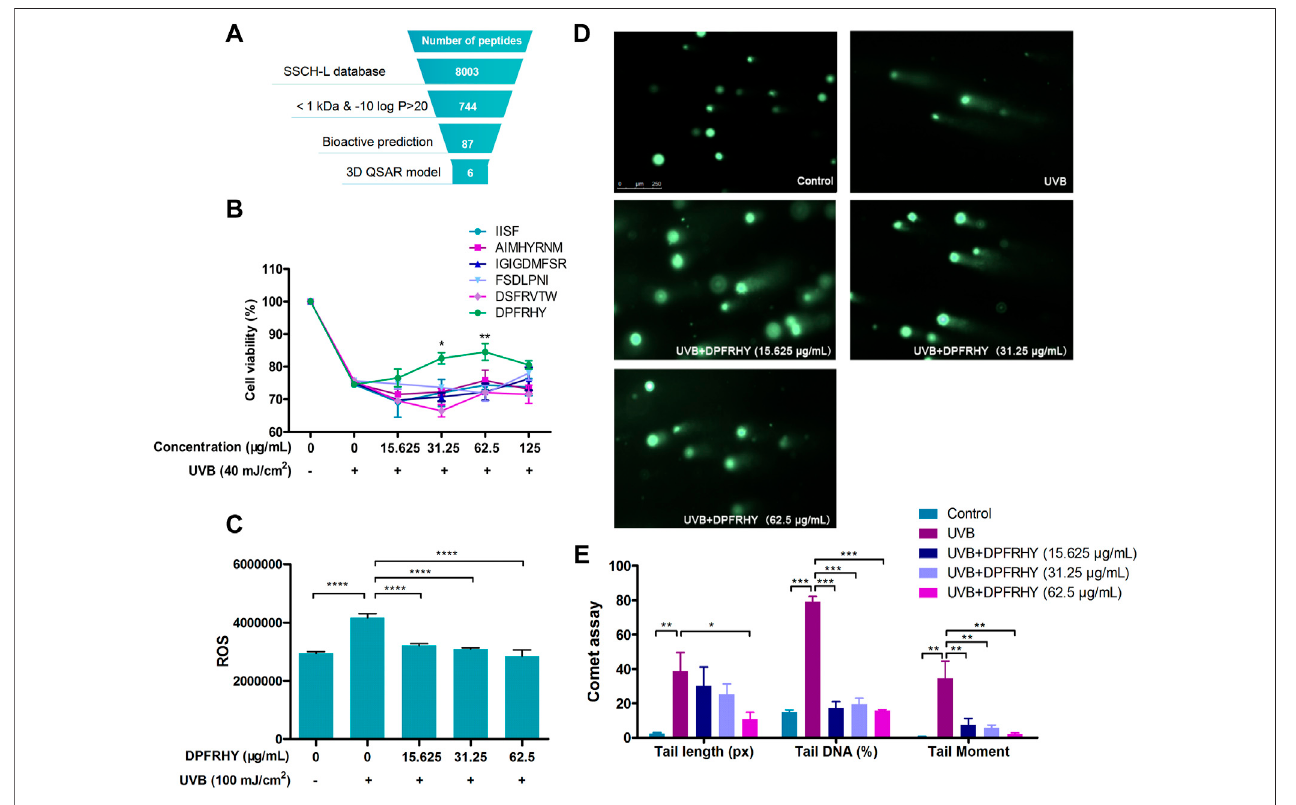
FIGURE 10 | Screening and photo-protective effect of DPFRHY. (A) . Schematic representation of the virtual screening of antioxidant peptide from SSCH-L. (B) . The protective effects of 6 SSCH-L-screened peptides on L929 cells damaged by UVB radiation by cell viability assay. (C) . ROS scavenging effect of DPFRHY in UVB exposed L929 cell. (D) . Comet assay of L929 cells after UVB exposure and DPFRHY treatment. (E) . Quanti fi cation of comet scores of D by Cometscore 2.0